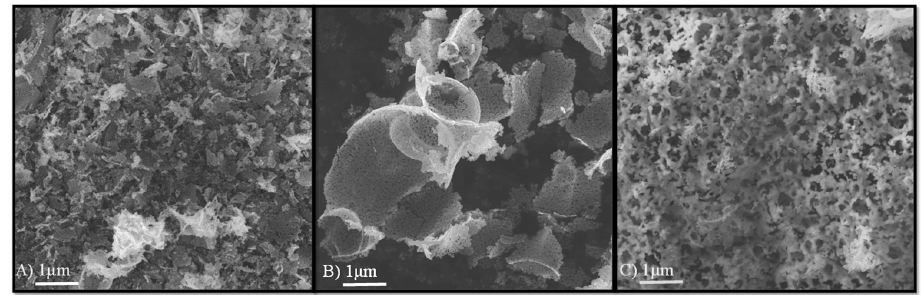
Figure 9. Secondary electron SEM images of LNO-600 ( A ), LNO-700 ( B ), and LNO-800 ( C ) sam- ples.